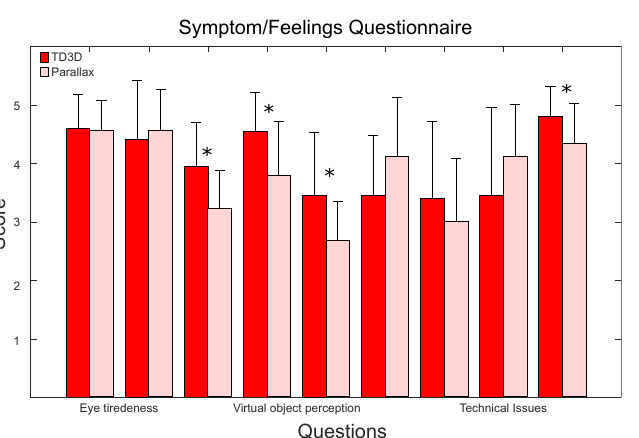
Fig. 6. Results from symptom/feelings questionnaire. Reported scores averaged across subjects are plotted for each of the nine questions. The dark red bars represent the scores for the stereoscopic TD3D sessions and the light red bars represent the scores for the motion parallax sessions. Error bars represent standard deviations across observers; * denotes a significance level of p < 0 : 025 for within-subjects